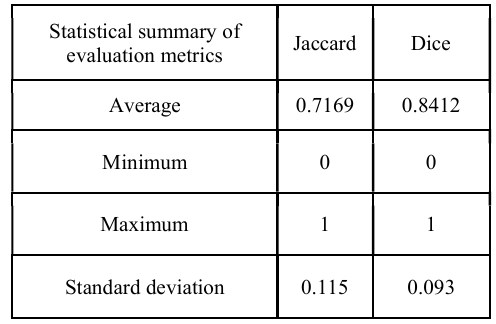
Table 1. Statistical summary of the evaluation metrics obtained by comparing the DeepLabV3+ model predicted images to the NDWI derived mask images (n =